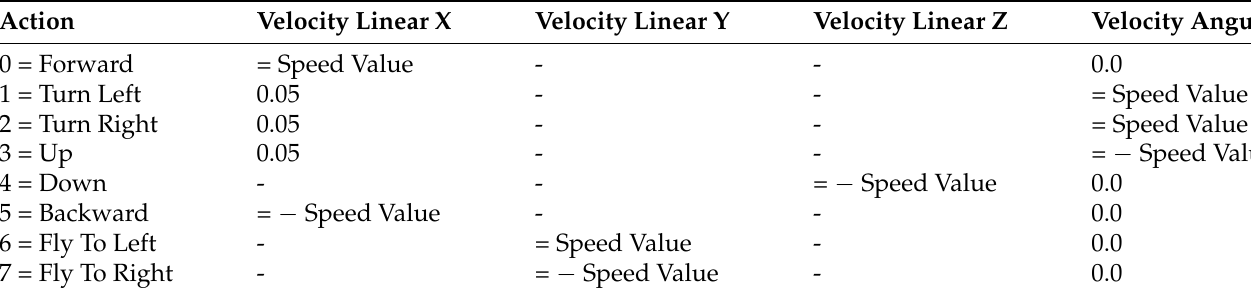
Figure 3. State, reward, agent, and environment interaction. Table 4. Velocity